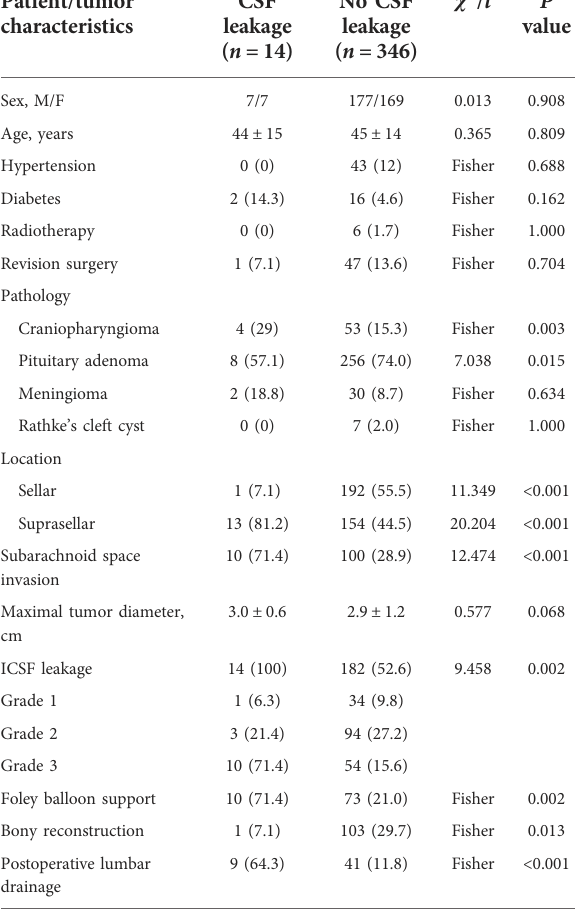
TABLE 3 Univariate analysis of factors affecting occurrence of postoperative CSF leakage.